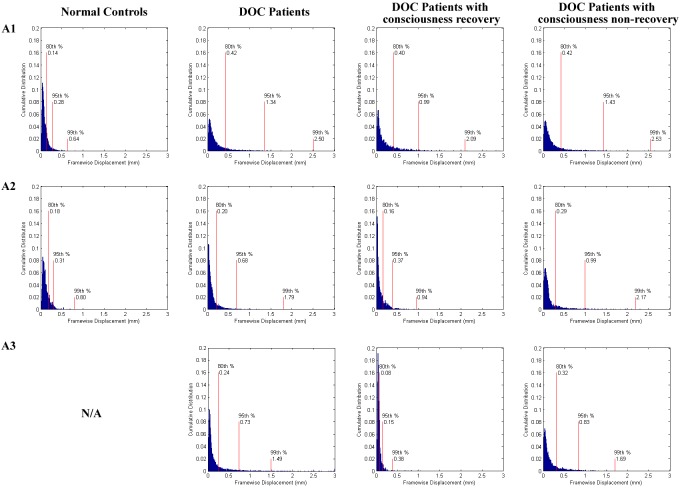
Cumulative distribution of head motion per volume (framewise displacement) for normal controls and DOC patients separately in the training dataset ‘Beijing 750’ (A1), the testing dataset ‘Beijing HDxt’ (A2), and the testing dataset ‘Guangzhou HDxt’ (A3).The normal controls were shown in left column, whereas the DOC patients were shown in right column. No healthy control data were available for the Guangzhou centre. In both patients and controls, head position was stable to within 1.5 mm for the vast majority (>95%) of brain volumes.